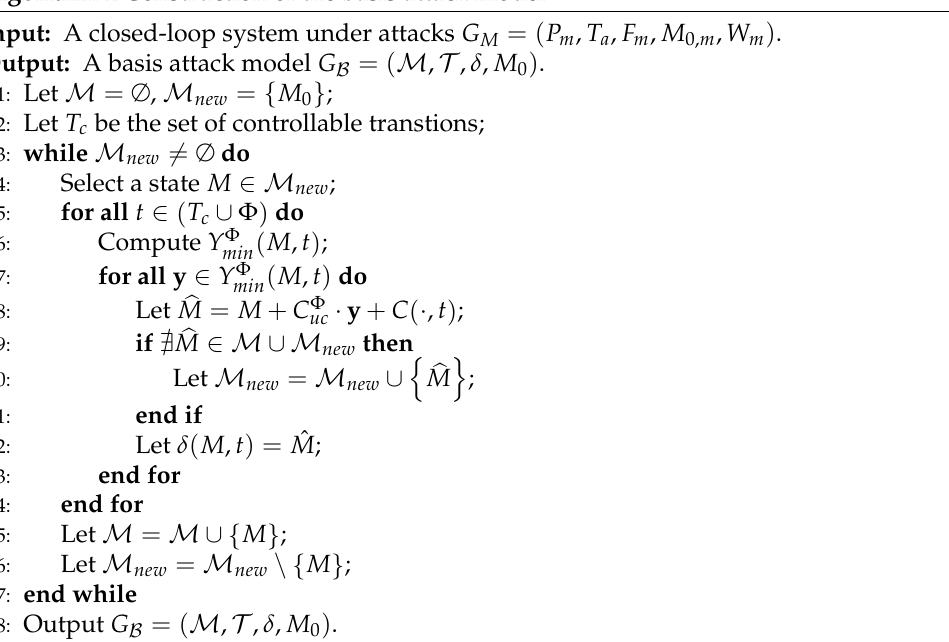
Algorithm 2 Construction of the basis attack